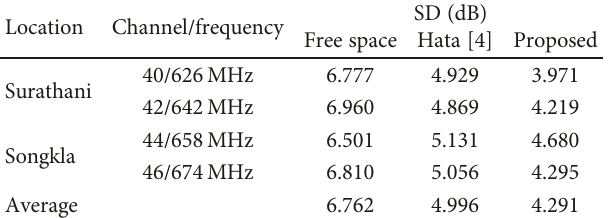
Table 5: SD calculative values.